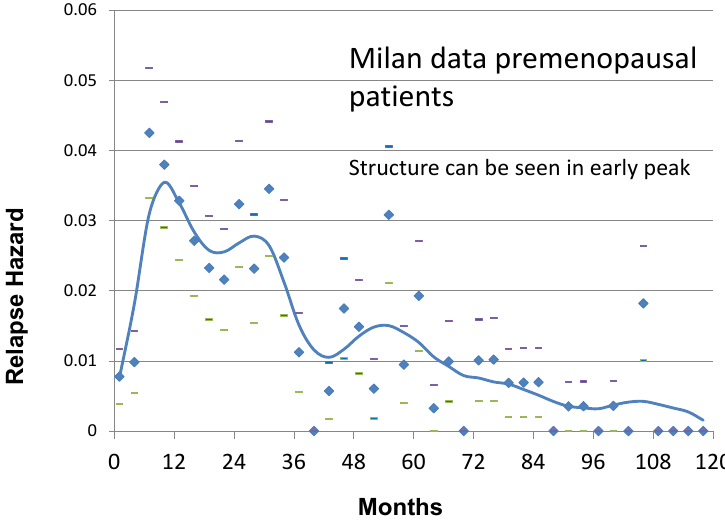
Figure 1. Recurrence hazard rate for Milan premenopausal